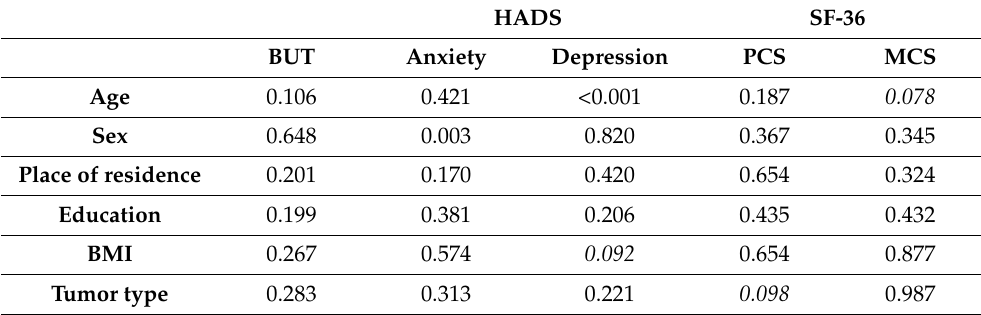
Tumor type 0.283 0.313 0.221 0.098